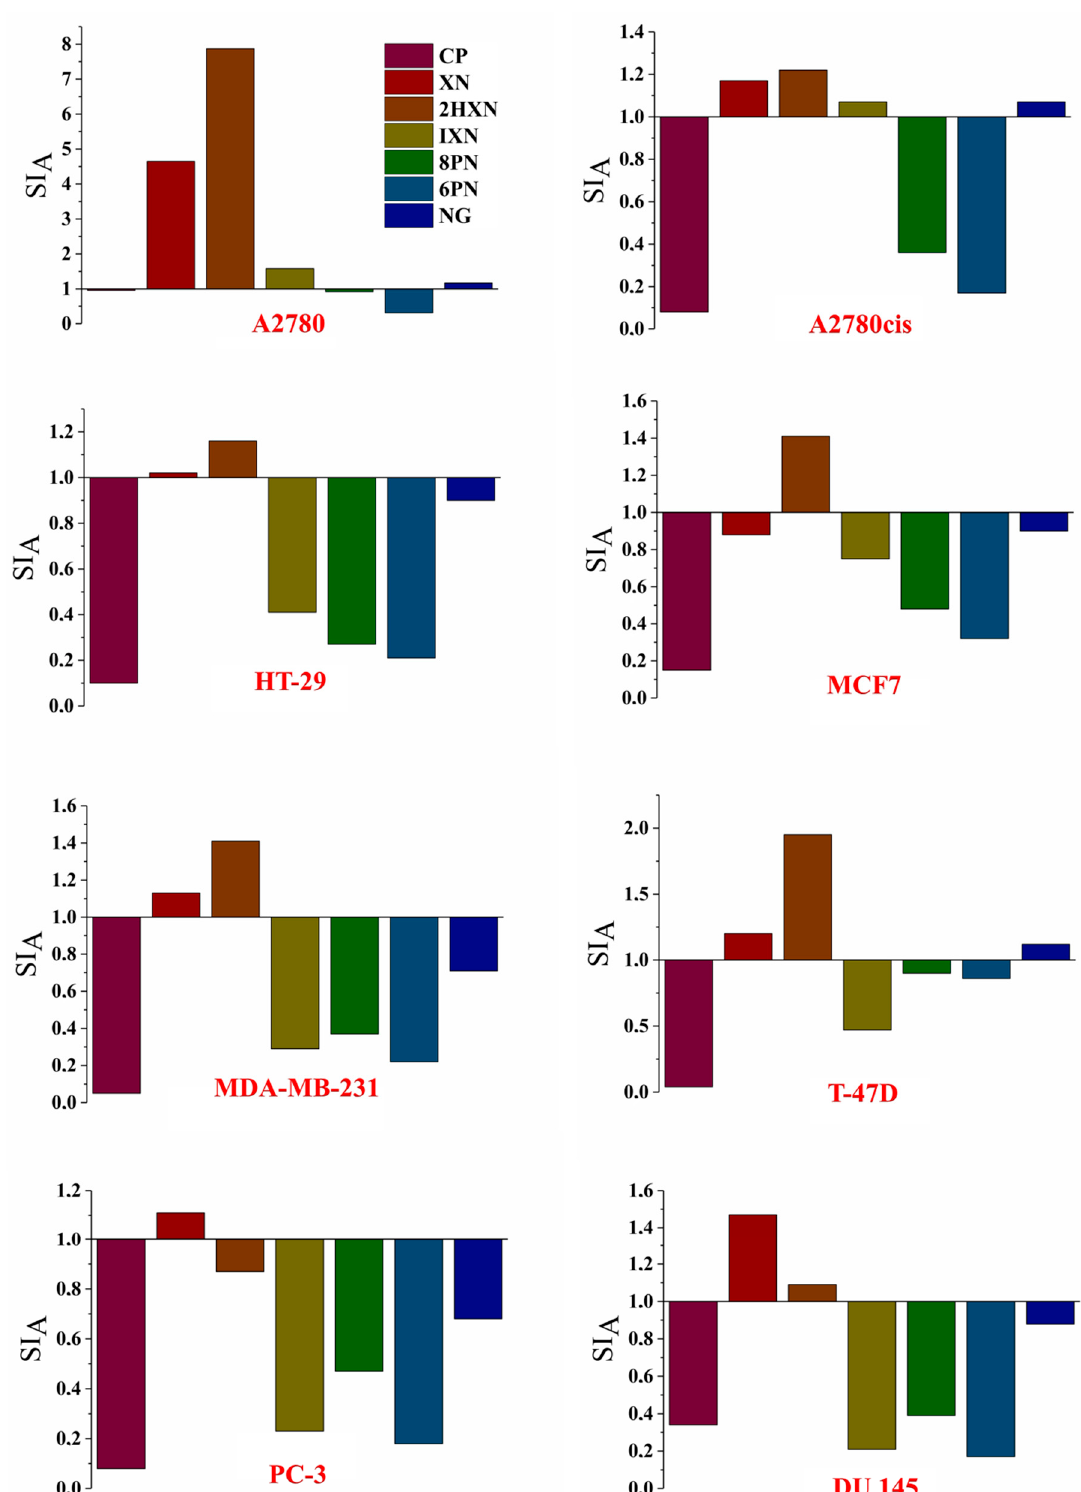
Figure 3. The selectivity indexes (SI A ) which represents IC 50 for a normal cell line (HLMEC)/IC 50 and for a cancerous cell line.